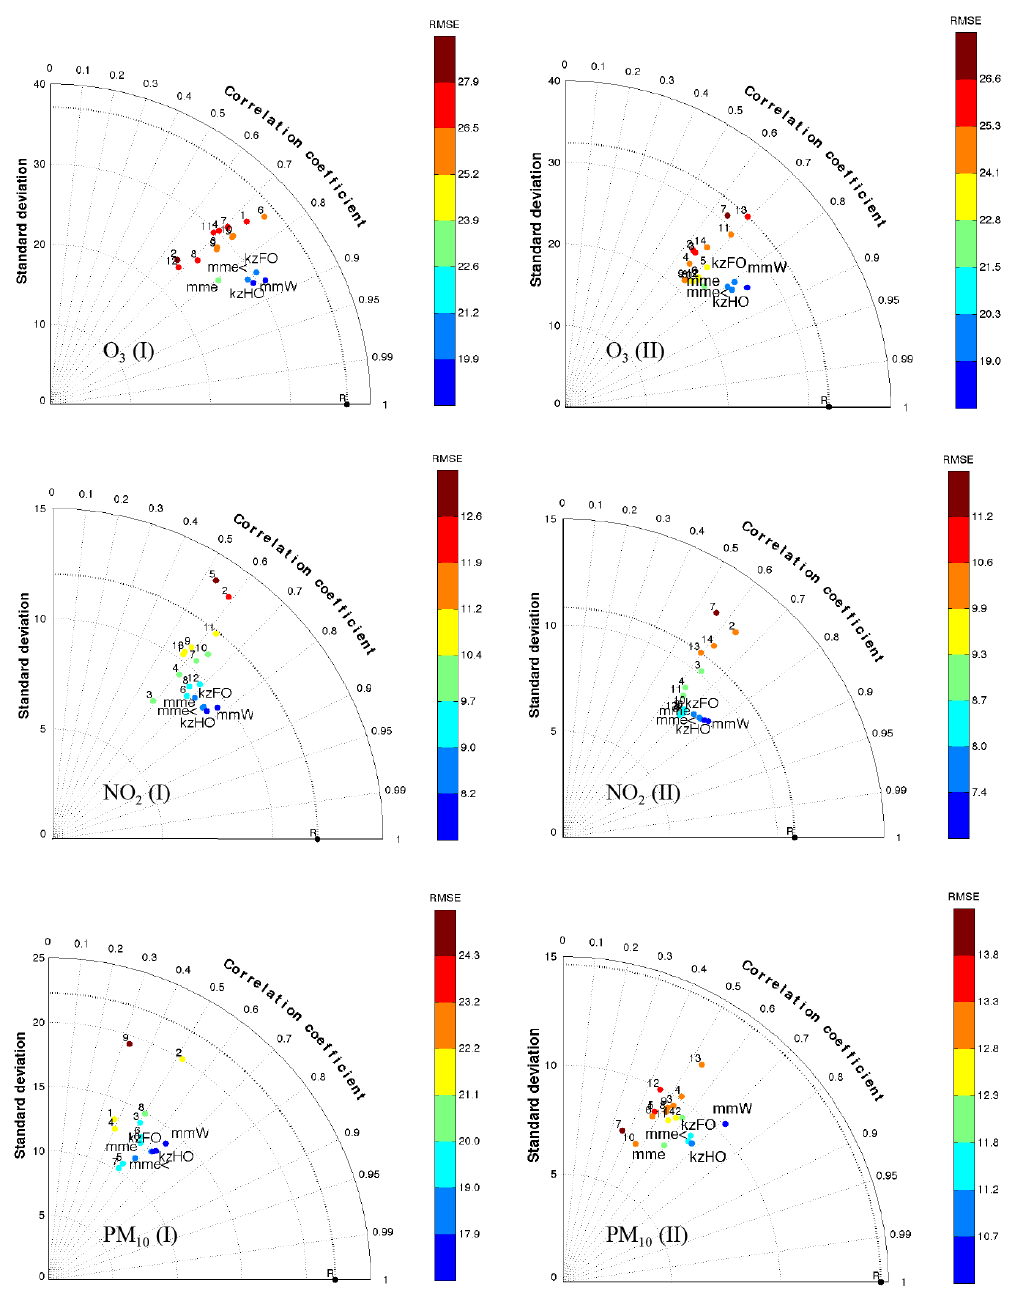
Figure 7. Composite skill of all deterministic models and ensemble estimators (mme, mme < , kzFO, kzHO, mmW) through Taylor plots. The point R represents the reference point (i.e.